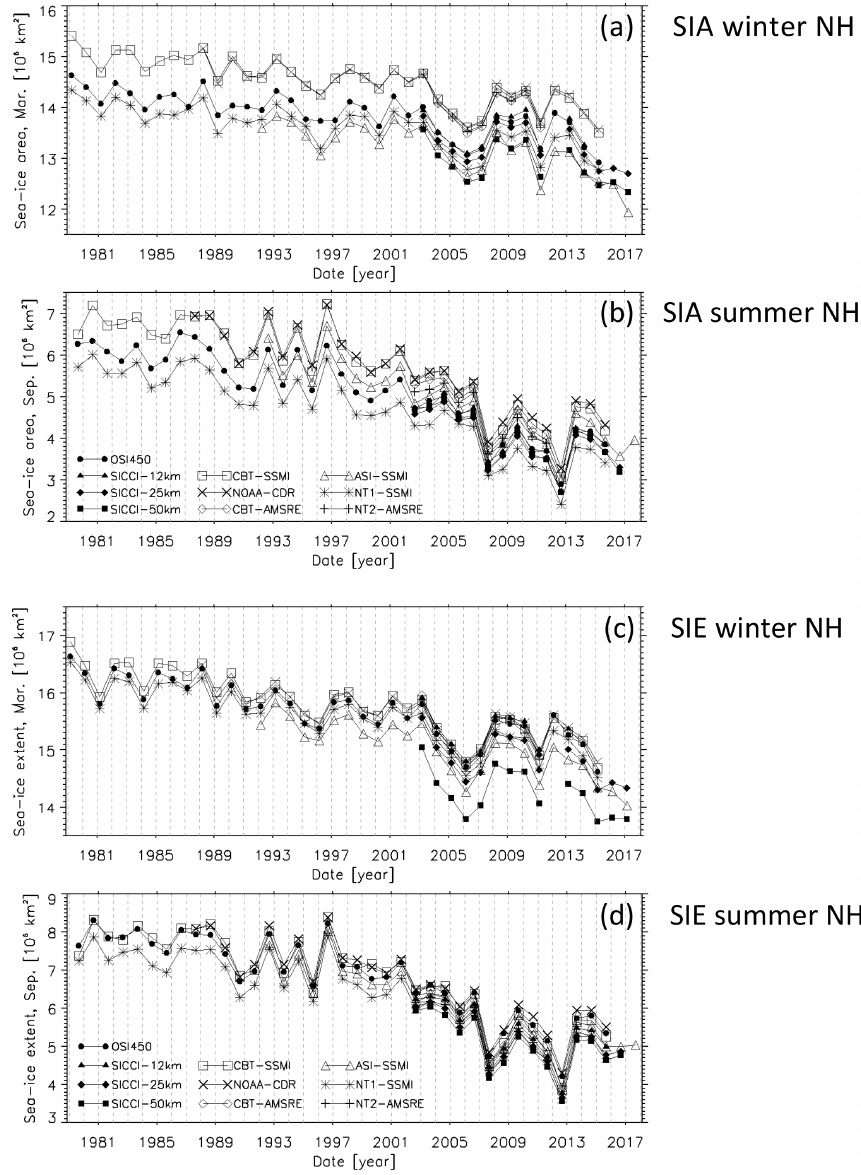
Figure 6. Arctic sea-ice area (a, b) and extent (c, d) computed in (a, c) winter (March) and (b, d) summer (September) from the sea-ice concentration data sets used. See Table 2 for start and end months of the respective time